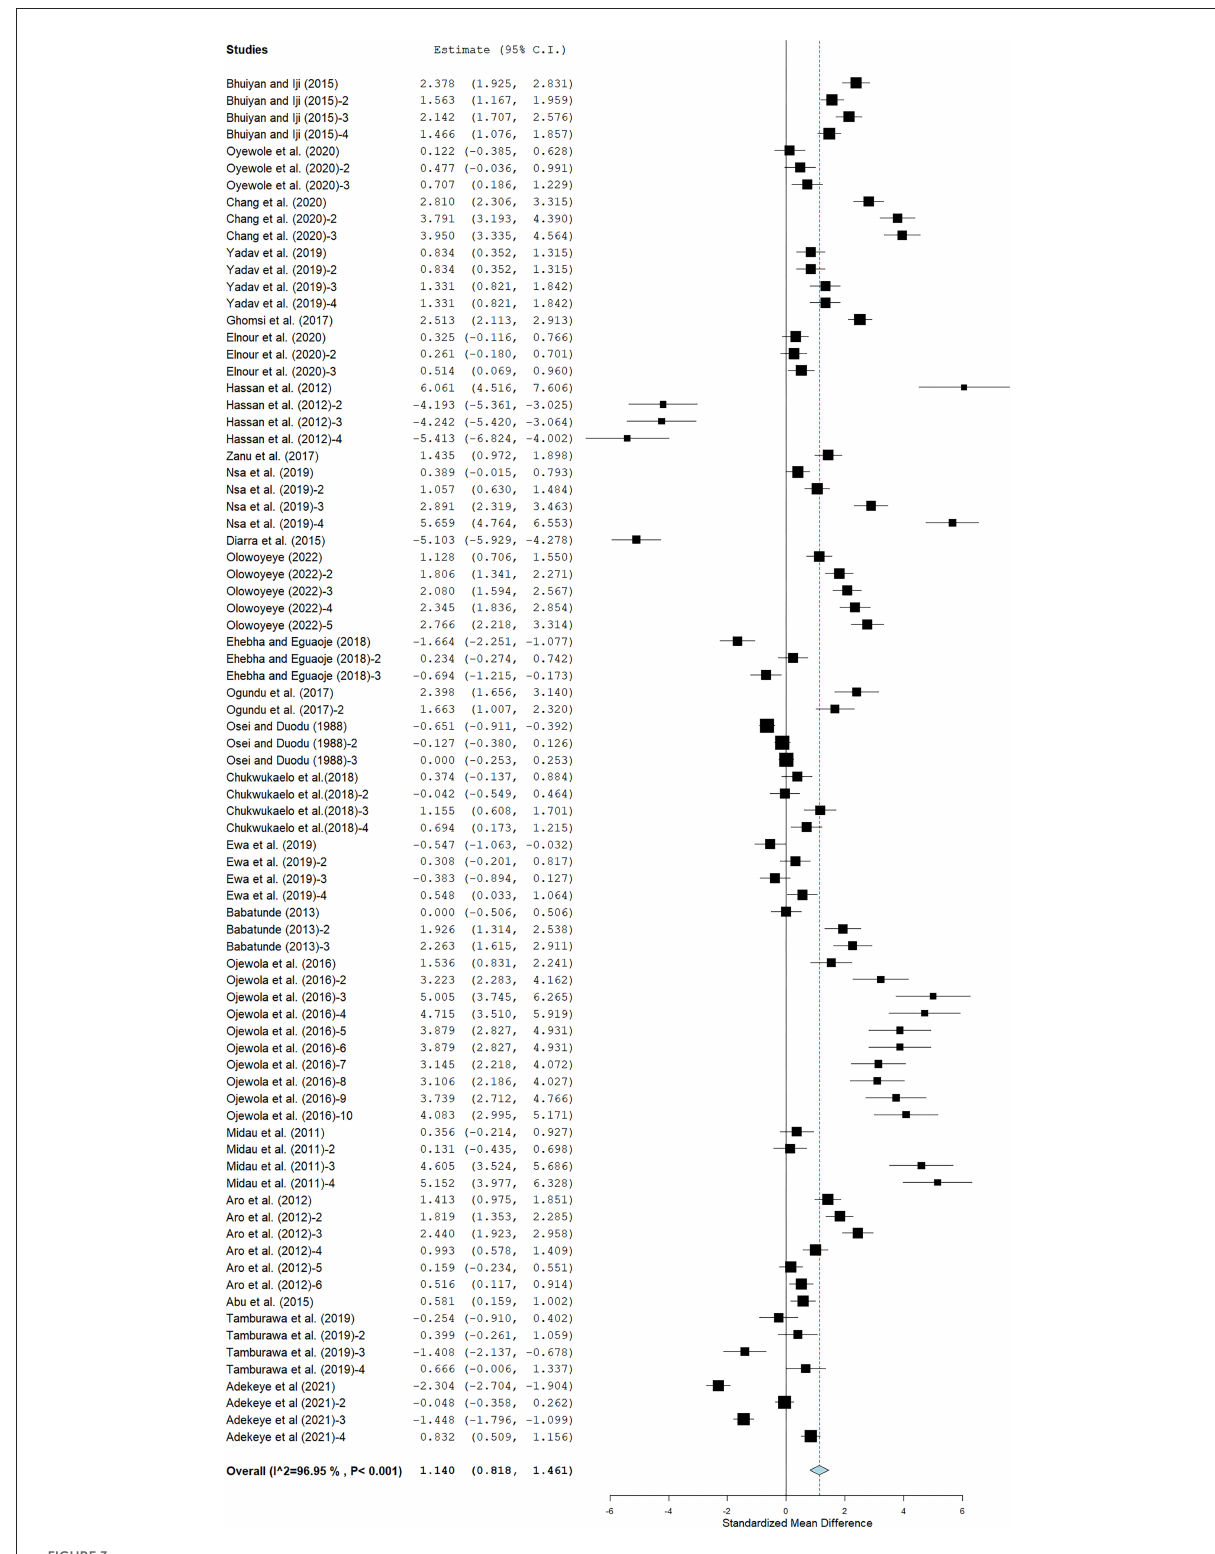
FIGURE3 MEB of the impact of cassava on FCR of broiler chickens. The thick vertical line is the line of no effect. Plots to the left of the solid vertical line show a decrease in FCR, whereas plots to the right show an increase in FCR.